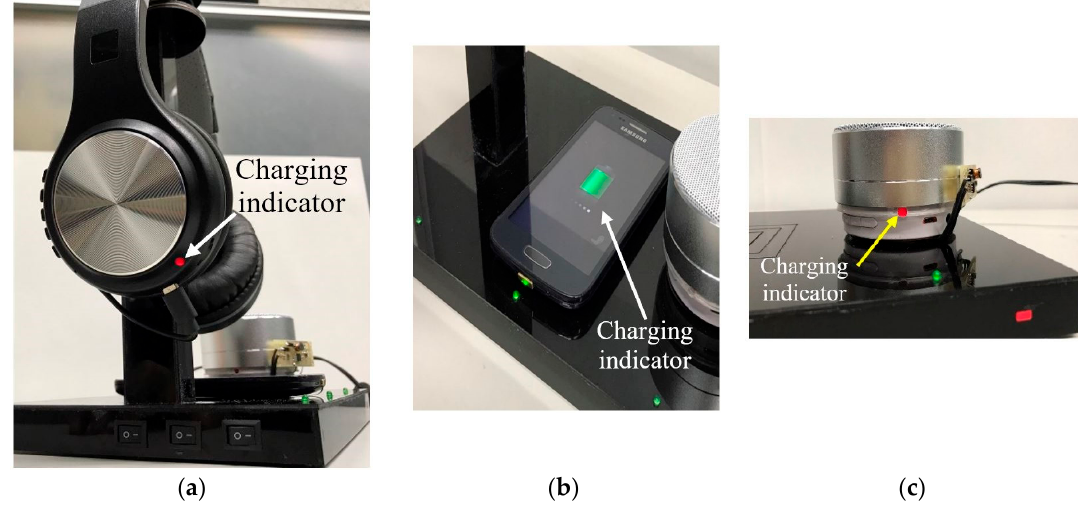
Figure 20. Built-in battery charging testing: ( a ) charging testing on wireless headphone; ( b ) charging testing on smartphone; ( c ) charging testing on wireless portable audio speaker.